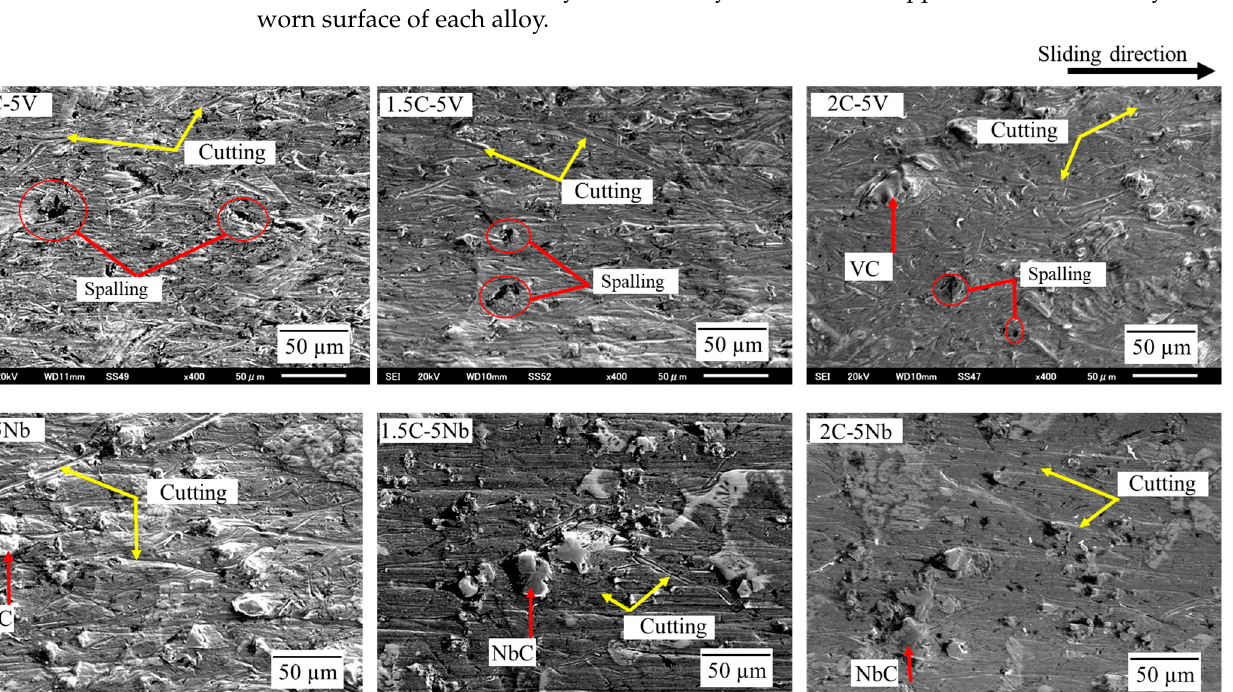
Figure 12. Investigation of abrasive wear mechanisms via the cross-section of the worn surface of each alloy studied. 4. Conclusions The wear behavior characteristics of 5V/5Nb-5Cr-5Mo-5W-5Co-Fe multicomponent cast alloys with varying C percentages under three-body abrasive wear conditions were examined in the present study. The results obtained can be summarized as follows: